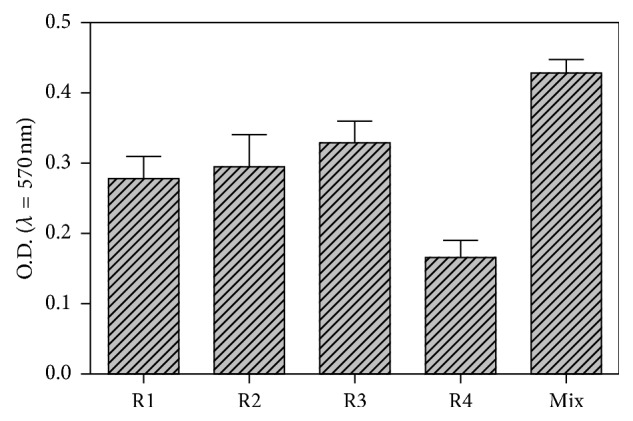
Total biomass of monomicrobial and polymicrobial biofilms of the diary isolates adhered on polystyrene. Negative (OD ≤ ODc), weak (ODc ≤ OD ≤ 2.ODc), moderate (2.ODc < OD ≤ 4.ODc), and strong biofilm production (4.ODc < OD). Mix = R1 + R2 + R3 + R4; OD = optical density.